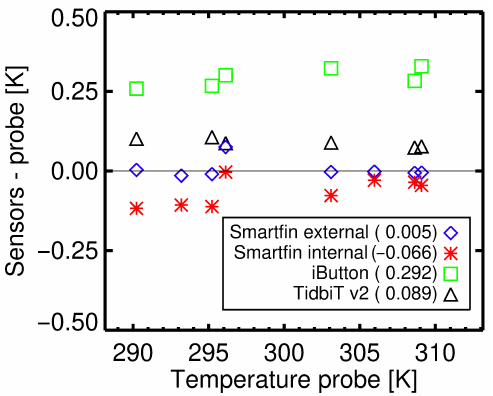
Figure 2. Comparison of the temperature sensors (Smartfin, iButton and TidbiT v2) used on the Simple Oceanographic floating Device (SOD) with an NPL-traceable Hart Scientific 1504 temperature bridge and Themometrics ES 225 temperature probe in a recirculating water bath